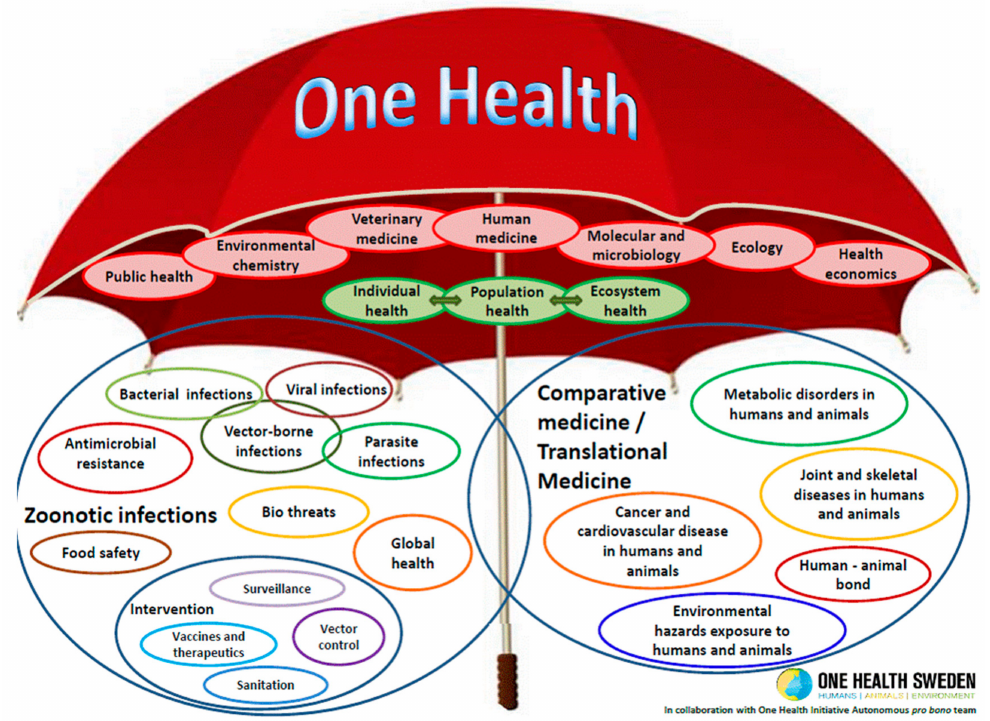
Figure 1. The One Health Umbrella, developed by One Health Sweden and the One Health Initiative Autonomous pro bono